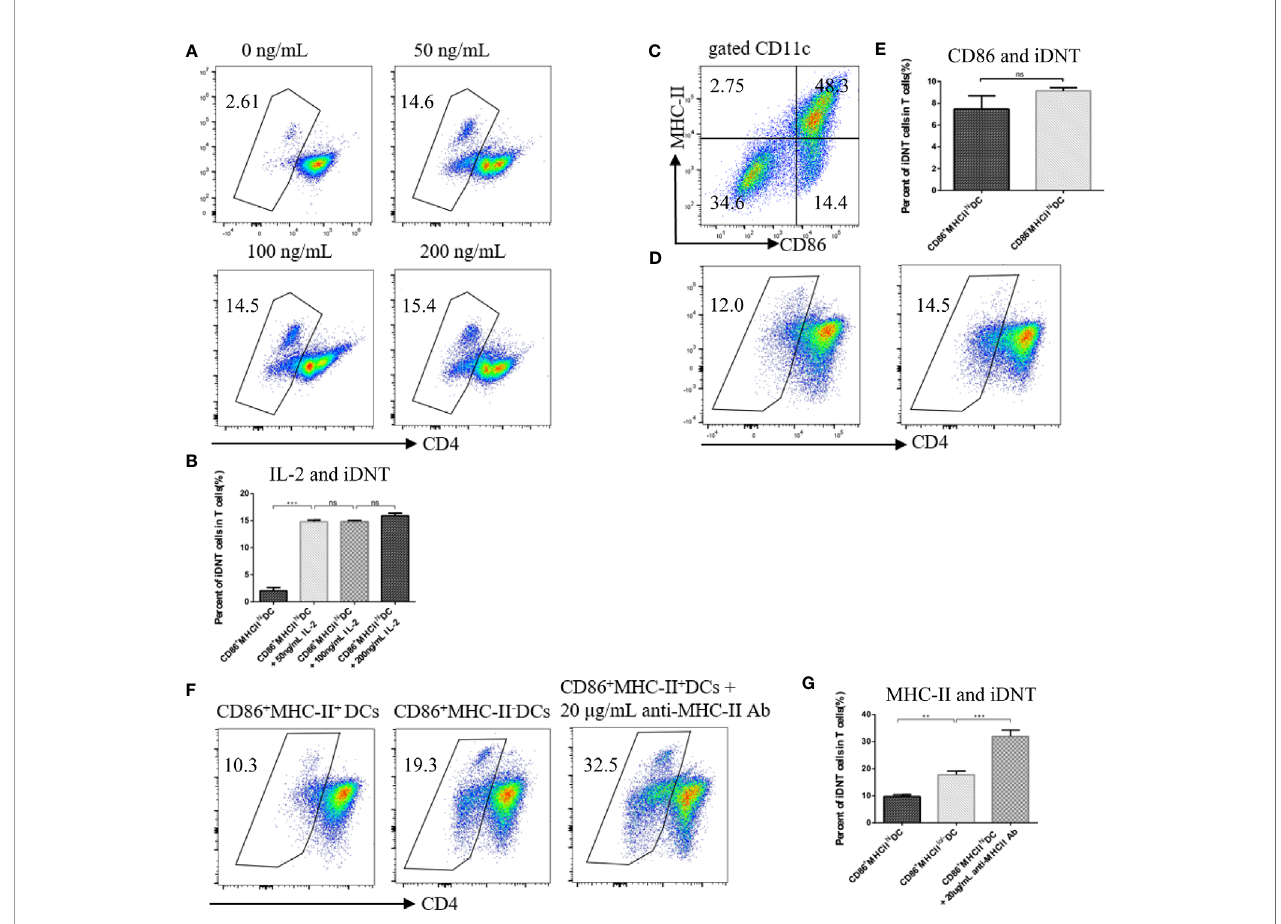
FIGURE 1 | MHC class II impedes the induction of nonregulatory CD4 + T cells into iDNT cells. (A, B) Freshly sorted CD4 + CD127 hi CD25 - T cells were cocultured with mature bone marrow dendritic cells (CD86 - MHC-II + DCs) at a ratio of 1×10 5 T cells to 2.5×10 4 DCs for up to 7 days in 96-well round-bottom plates in complete RPMI 1640. Different concentrations of IL-2 (0, 50 ng/mL, 100 ng/mL or 200 ng/mL) were added to the culture system. TCR ab + CD3 + CD4 - CD8 - iDNT cells were analyzed to evaluate the in fl uence of IL-2 on induction. (A) The TCR ab + CD3 + CD4 - CD8 - cell population is gated. Representative fl ow cytometry pro fi les of different concentrations of IL-2 (0, 50 ng/mL, 100 ng/mL or 200 ng/mL). (B) The bar graphs are representative of three independent experiments. (C) Representative data of the use of anti-CD86 and anti-MHC-II antibodies to divide bone marrow DCs into two subgroups: mature DCs (CD86 + MHC-II + ) and immature DCs (CD86 - MHC-II + , CD86 + MHC-II - or CD86 - MHC-II - ). (D, E) Immature DCs (CD86 - MHC-II + ) or mature DCs (CD86 + MHC-II + ) were cocultured with freshly sorted nonregulatory CD4 + T cells. IL-2 (50 ng/mL) was added to the culture system. iDNT cells were analyzed to evaluate the in fl uence of CD86 on induction. (D) Representative fl ow cytometry pro fi les of these two mixed lymphocyte reactions. (E) The bar graphs are representative of three independent experiments. (F, G) Immature DCs (CD86 + MHC-II - ), mature DCs (CD86 + MHC-II + ) or mature DCs with anti-MHC-II antibody (20 m g/mL) were cocultured with freshly sorted nonregulatory CD4 + T cells. IL-2 (50 ng/mL) was added to the culture system. iDNT cells were analyzed to evaluate the in fl uence of MHC class II on induction. (F) Representative fl ow cytometry pro fi les of these three mixed lymphocyte reactions. (G) The bar graphs are representative of three independent experiments. Student ’ s t -test was used to compare two independent variables (ns, not signi fi cant, ** p < 0.01, and *** p <